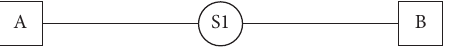
Figure 1: Topology used in packet reordering tests: A is the traffic source, S1 is an intermediate node that limits bandwidth, delay, and generates packet reordering, and B is the traffic destination.